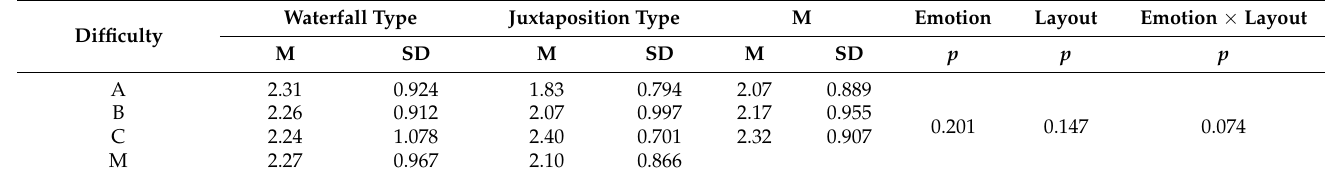
Table 4. Descriptive statistics and two-way ANOVA for the difficulty of the lesson.